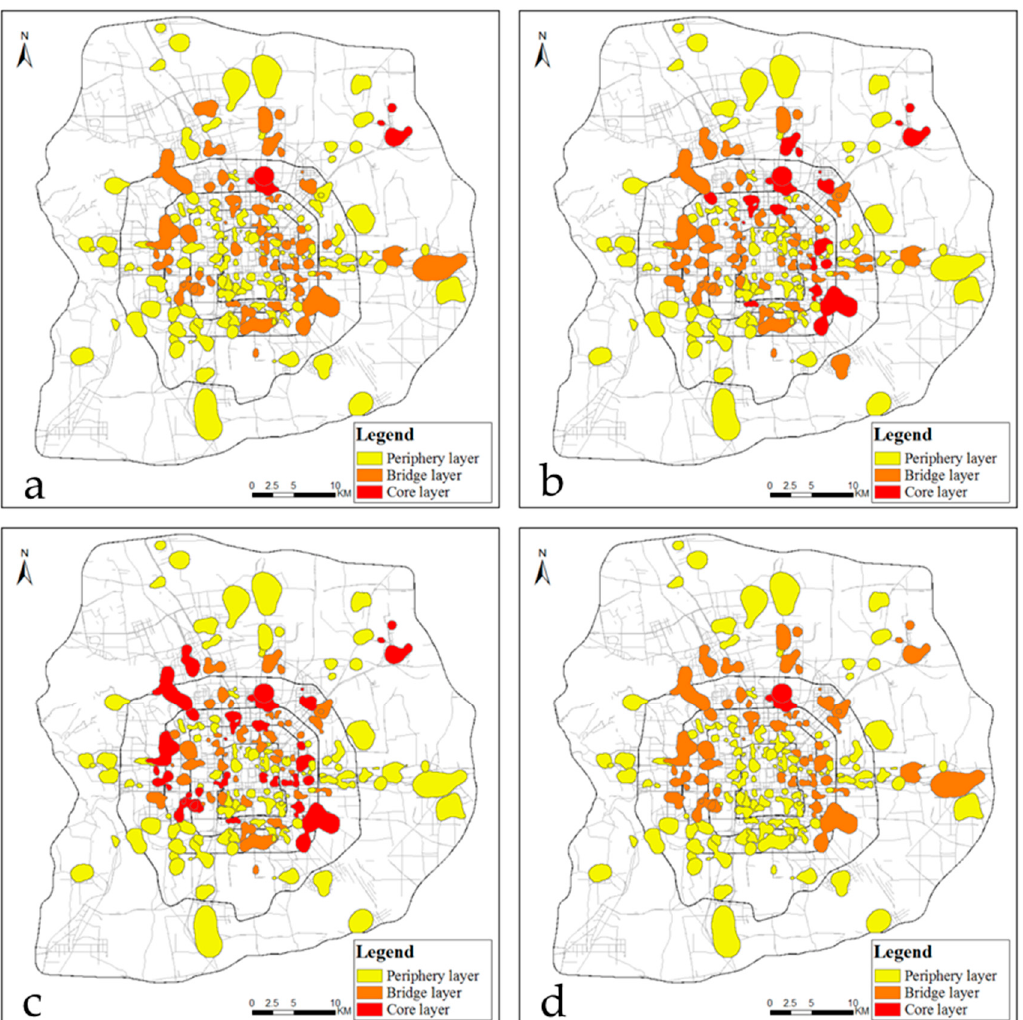
Figure 6. Distribution of all places in different periods in three layers on weekdays. ( a ) Early morning; ( b ) morning; ( c ) afternoon; and ( d ) evening.